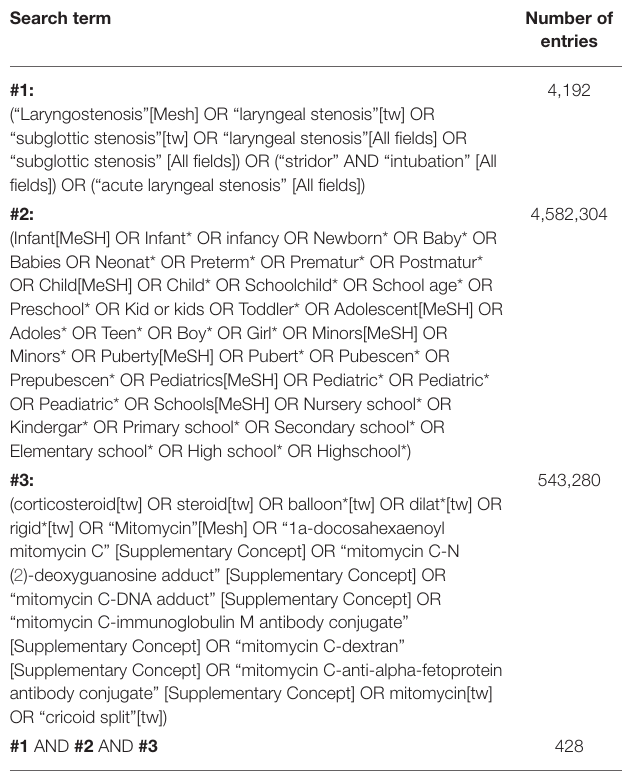
TABLE 2 | Search strategy for MEDLINE (accessed: